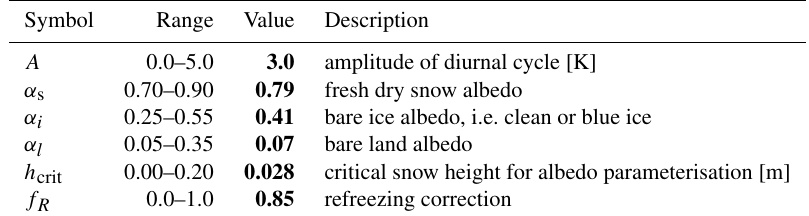
Table 3. Model parameters with their initial range and their optimal value in bold